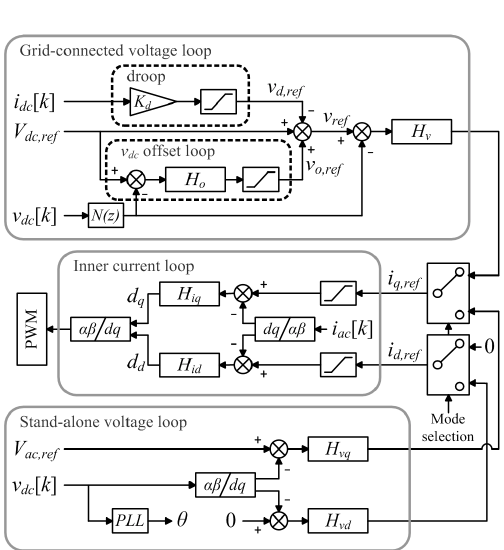
Figure 6. Control diagram of GC local controller.